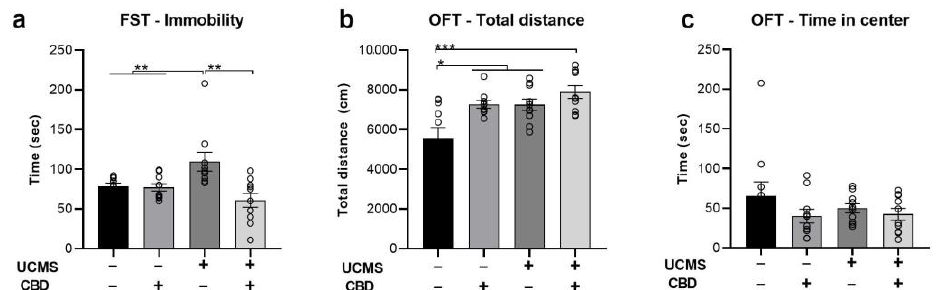
Figure 1. The effects of CBD treatment on behavior in rats exposed to UCMS. ( a ) FST: UCMS rats treated with a vehicle spent more time immobile than the No UCMS groups and UCMS rats treated with CBD. ( b ) OFT total distance: No UCMS rats treated with the vehicle covered less distance com- pared to all groups. ( c ) OFT time in the center: no differences between groups were observed. FST — forced swim test; OFT — open field test; UCMS: unpredictable chronic mild stress; CBD: cannabidiol. *, p < 0.05, **, p < 0.01, ***, p < 0.001.